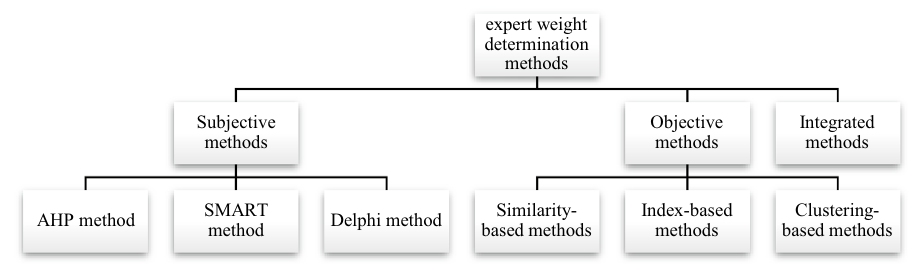
Figure 3. Classification of weight determination